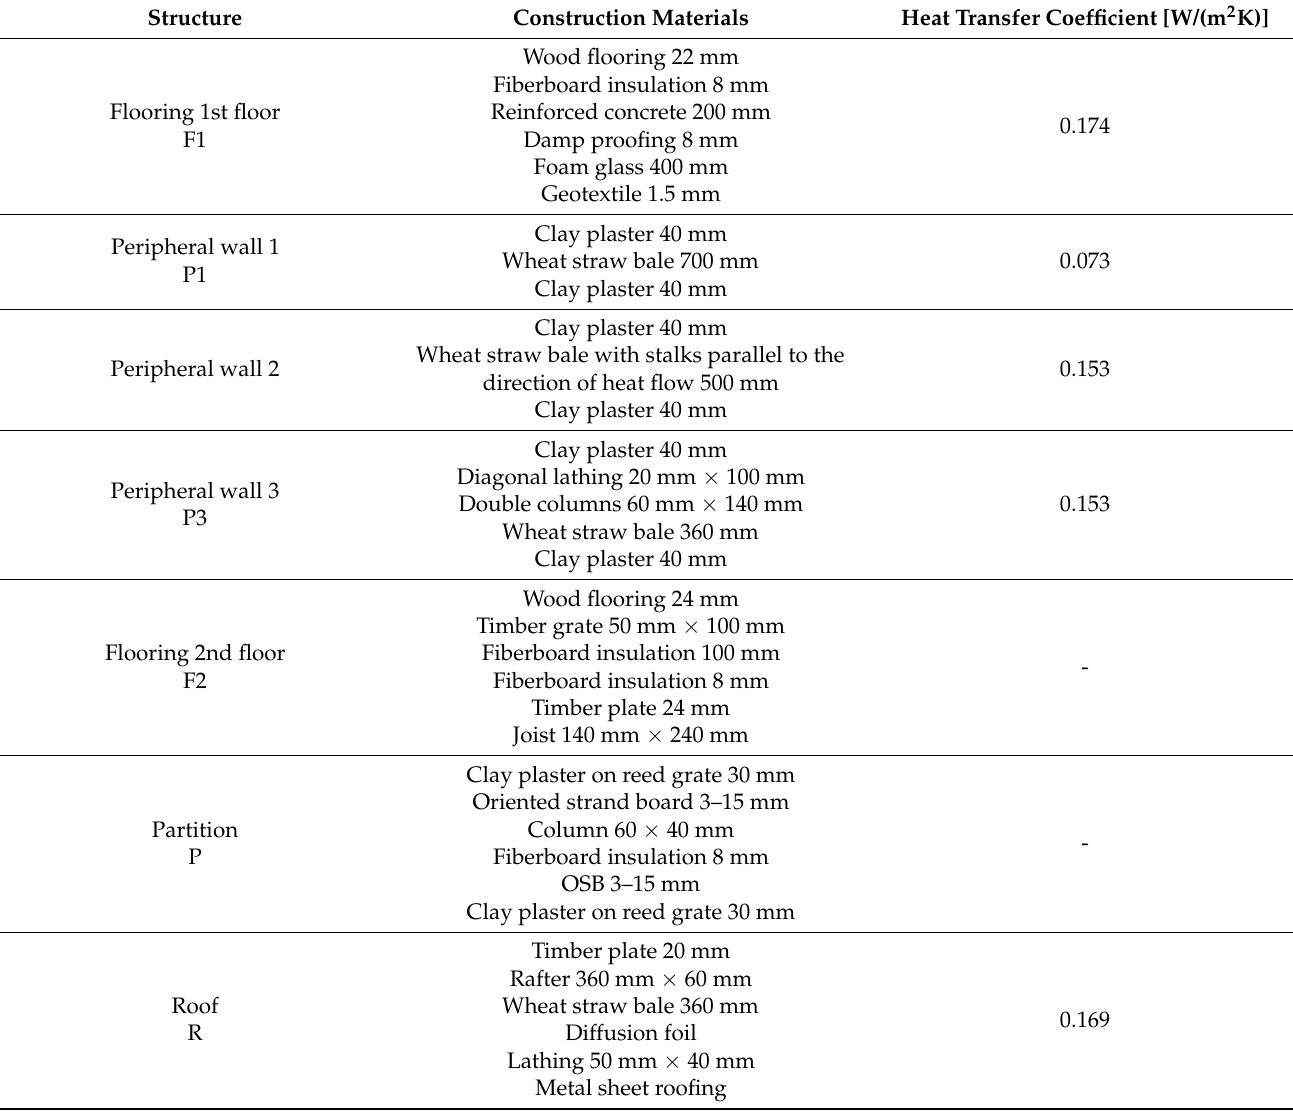
Table 2. Material composition and heat transfer coefficient of the